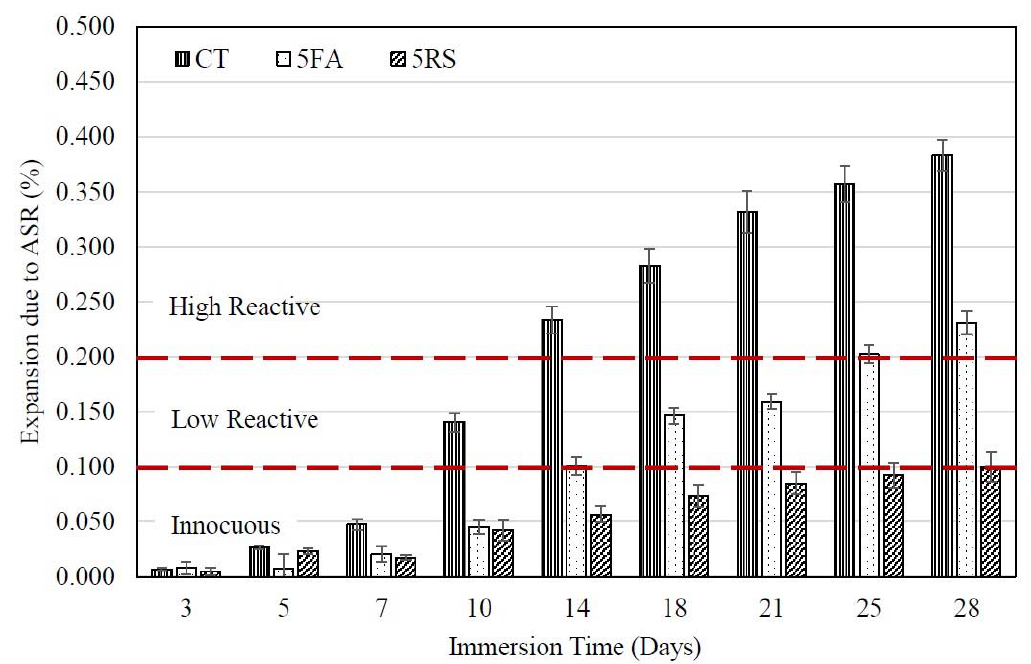
Figure 6. Relationship between the ASR expansion of 5FA and 5RS mortars and immersion time.